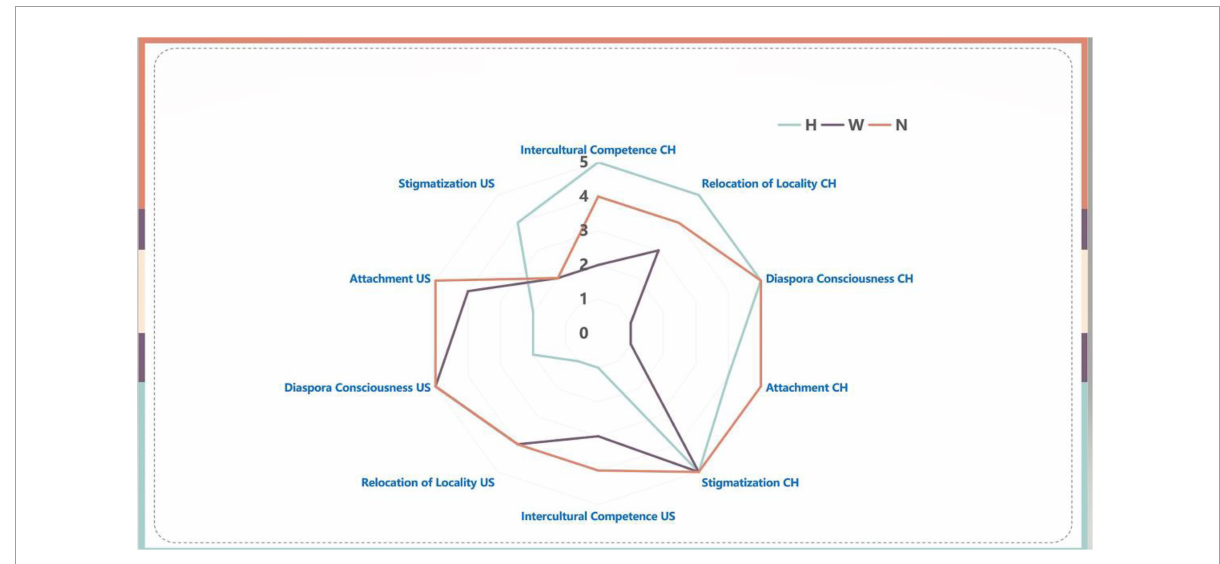
FIGURE4 Identity shifts of the three identity clusters after the double